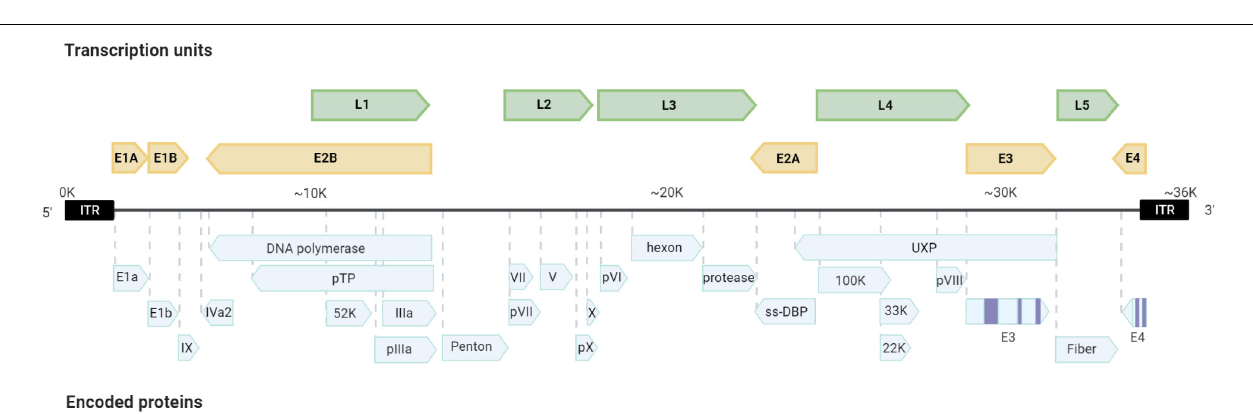
FIGURE 2 | Scheme of the adenoviral genome. The organization of the transcription units and encoded proteins are